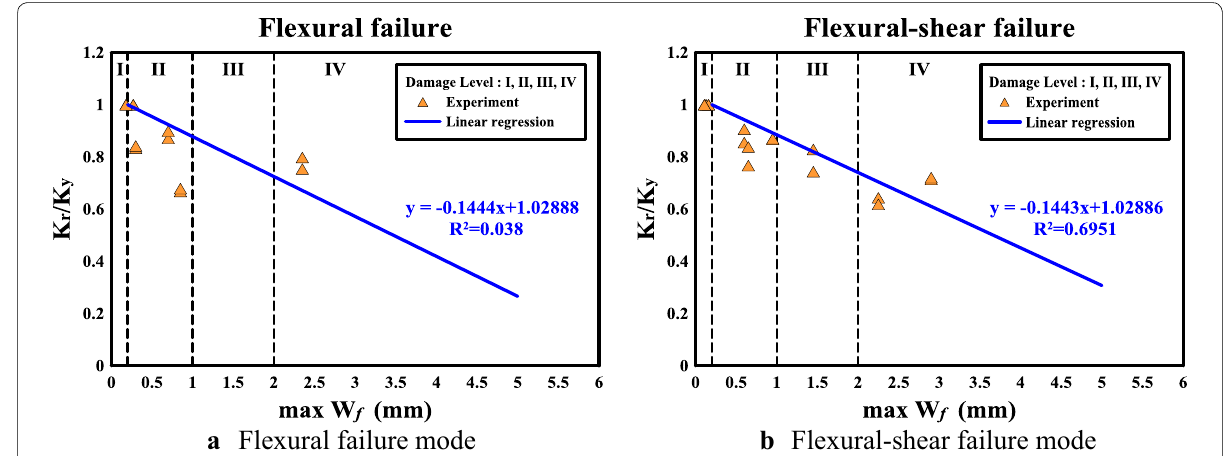
Fig. 17 Reduction factors of stiffness related to various damage levels for the specimens with the flexural and flexural–shear failure modes.